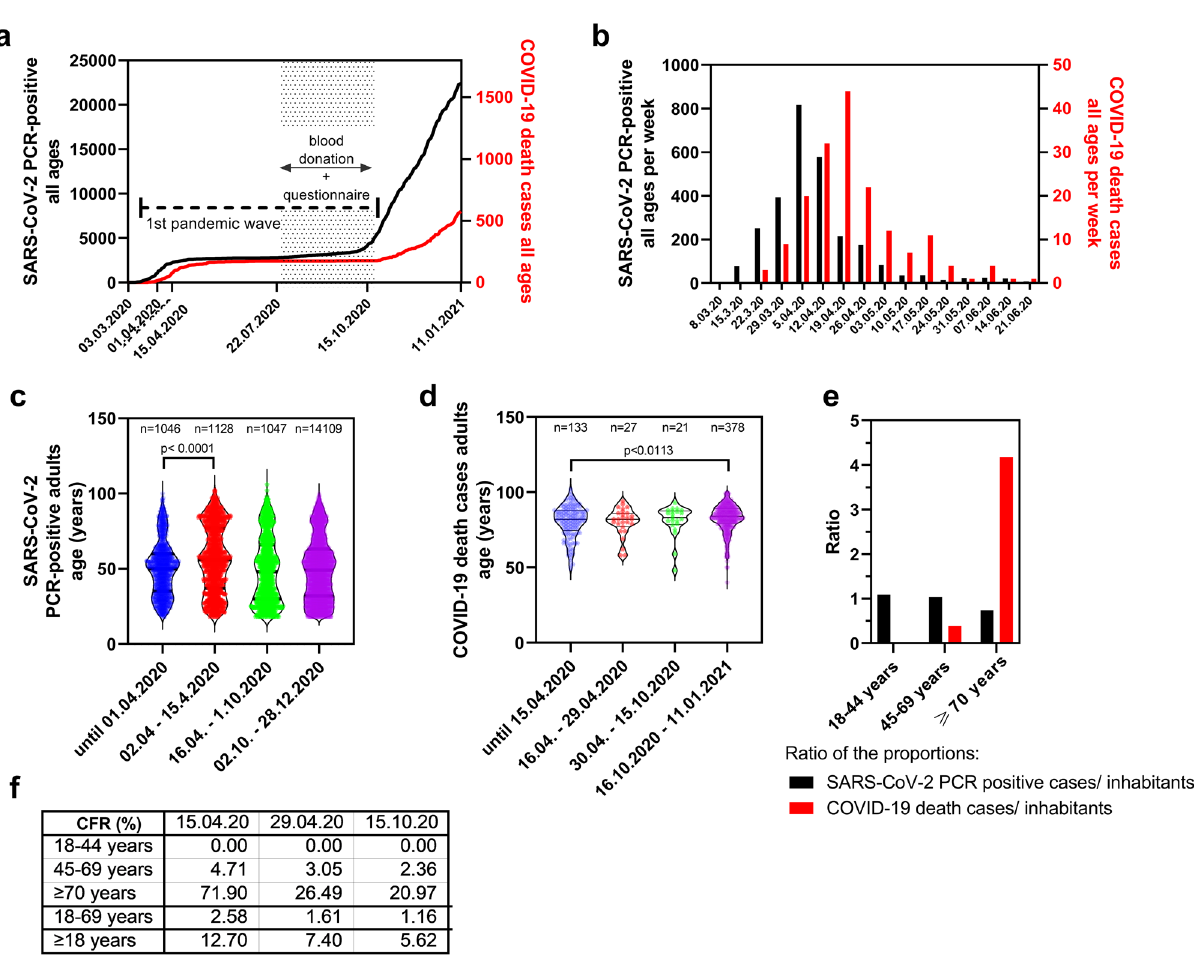
Fig. 3 SARS-CoV-2 PCR-con fi rmed cases in Saarland: Time course, mean age and death cases. a Reported SARS-CoV-2 PCR-positive cumulative infections (black) and deaths (red) in Saarland from March 3, 2020 to January 11, 2021 (data source: Saarland Ministry of Health). First pandemic wave and time frame of the seroprevalence study (July 22 to October 15, 2020) are indicated. b SARS-CoV-2 PCR-positive cases (black) and COVID-19 death cases (red) in Saarland per calendar week. c Violin plot with median ages of PCR-positive cases during the indicated time intervals. (until 01.04.2020 n = 1046; 02.04. – 15.04.2020 n = 1128; 16.04. – 01.10.2020 n = 1047; 02.10. – 28.12.2020 n = 14109). d Violin plot with median of death cases per age during the indicated time intervals (time frames shifted for 14 days compared to b . Until 15.04.2020 n = 133; 16.04. – 29.04.2020 n = 27; 30.04. – 15.10.2020 n = 21; 16.10.2020 – 11.01.2021 n = 378). Signi fi cances were calculated with unpaired two-sided t -test, p -values are depicted (B: t = 7.229, df = 2172; C: t = 2.543, df = 509). e Ratio of the proportion of SARS-CoV-2 PCR-con fi rmed cases by 01.04.2020 (black), or the proportion of COVID-19 death cases by 15.04.2020 (red) in the indicated age groups, relative to the proportion of Saarland inhabitants in the indicated age groups. f Time trends of case-fatality- rates (CFR) in Saarland at indicated time points for 18 – 44-, 45 – 69-year-old adults, elderly individuals ≥ 70 years, 18 – 69-year-old adults and all adults ( ≥ 18 years). Calculations are based on data in Supplementary Table